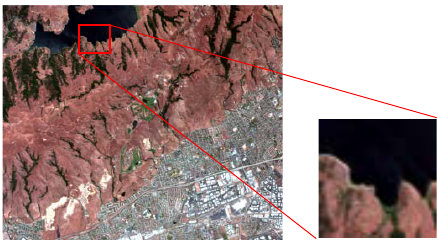
Figure 13. Region of interest in the Airborne Visible Infrared Imaging Spectrometer (AVIRIS) Moffett image.